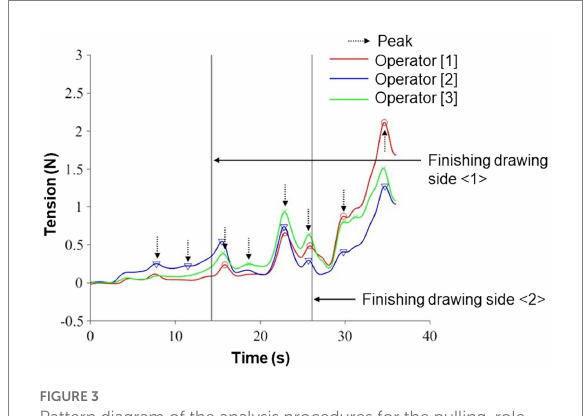
FIGURE 3 Pattern diagram of the analysis procedures for the pulling-role actions in Table 1 (see the “Role Actions” section). In this trial, the number of counts (defined as peak frequency) recorded tension peaks are 2, 4, and 2 on each side, shown by the dotted black arrows. These tensions corresponding to the vertical axis are averaged on each side, and it is regarded as the peak value. The same analysis was applied to those in the adjusting role. Meanwhile, in the relaxing role, the minimum one corresponding to the vertical axis was used on each side as the peak value considering the task